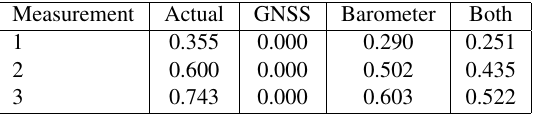
Table 4: Measurements for the Blocks